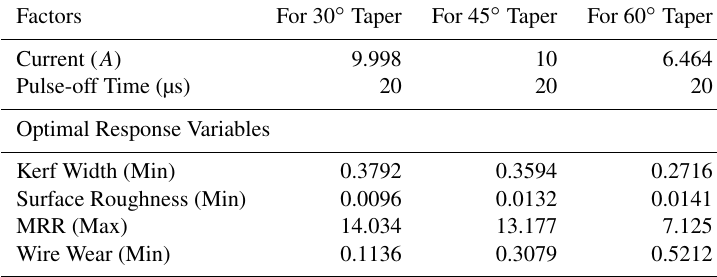
Table 8. Optimal factor values for the WEDM cut of titanium